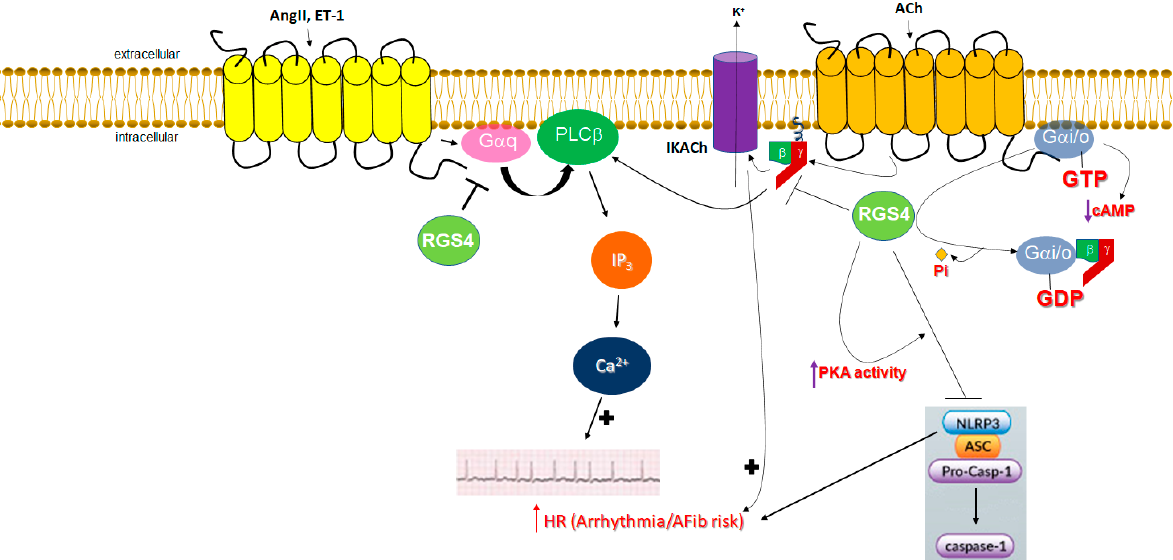
Figure 2. Role of (atrial) cardiomyocyte RGS4 in the context of human AFib. Note that the free Gi/o-protein-derived G βγ dimer can also activate certain isoforms of PLC β directly. Also depicted is the inhibitory effect of RGS4 on NLRP3 inflammasome (indirectly, via enhanced PKA-dependent phosphorylation) which awaits experimental confirmation. AngII: angiotensin II; ACh: acetylcholine; IP 3 : inositol 1 (cid:48) , 4 (cid:48) , 5 (cid:48) -trisphosphate; Pi: inorganic phosphate; ASC: apoptosis-associated speck-like protein containing a caspase recruitment domain (CARD); Pro-Casp-1: pro-caspase-1; HR: heart rate. See text for details and all other molecular acronym